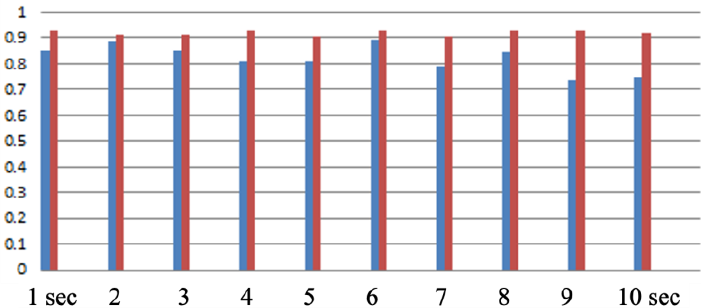
Figure 10. The recall values of input data average (blue bars for SVM and red bars for RF).